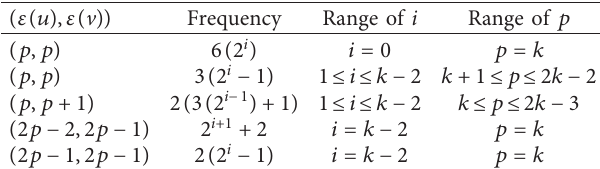
Table 4: Edge partition of an X -tree ( k -level) based on eccentricity of end vertices of each edge with existence of its